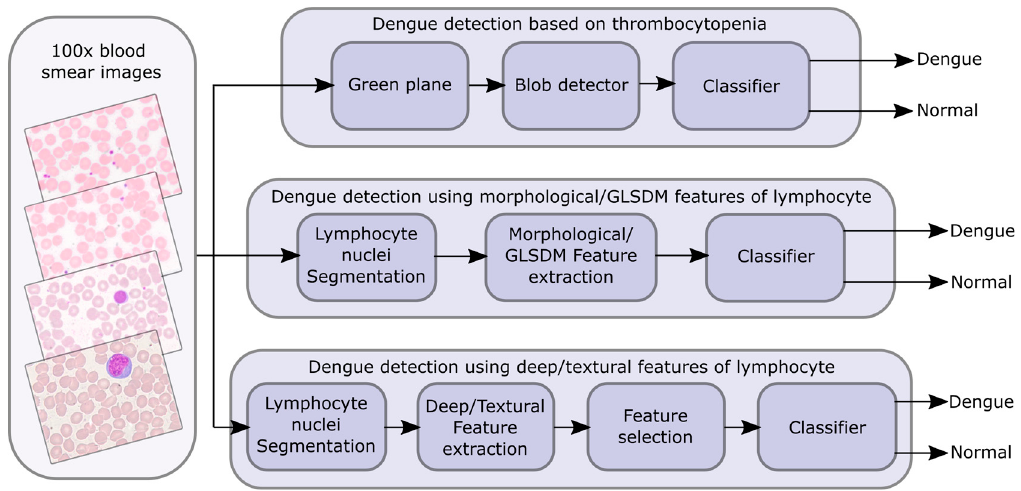
Figure 3. Conceptual layout of the planned dengue detection scheme.